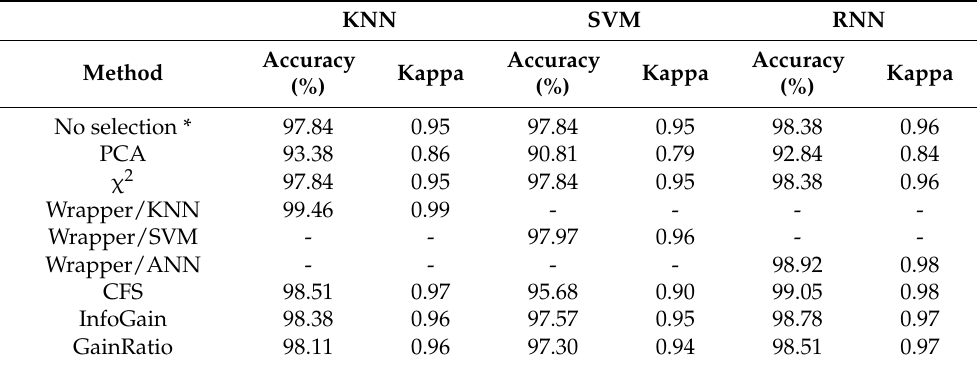
Table 8. Performance of the accuracy and kappa with Dataset 2 using four